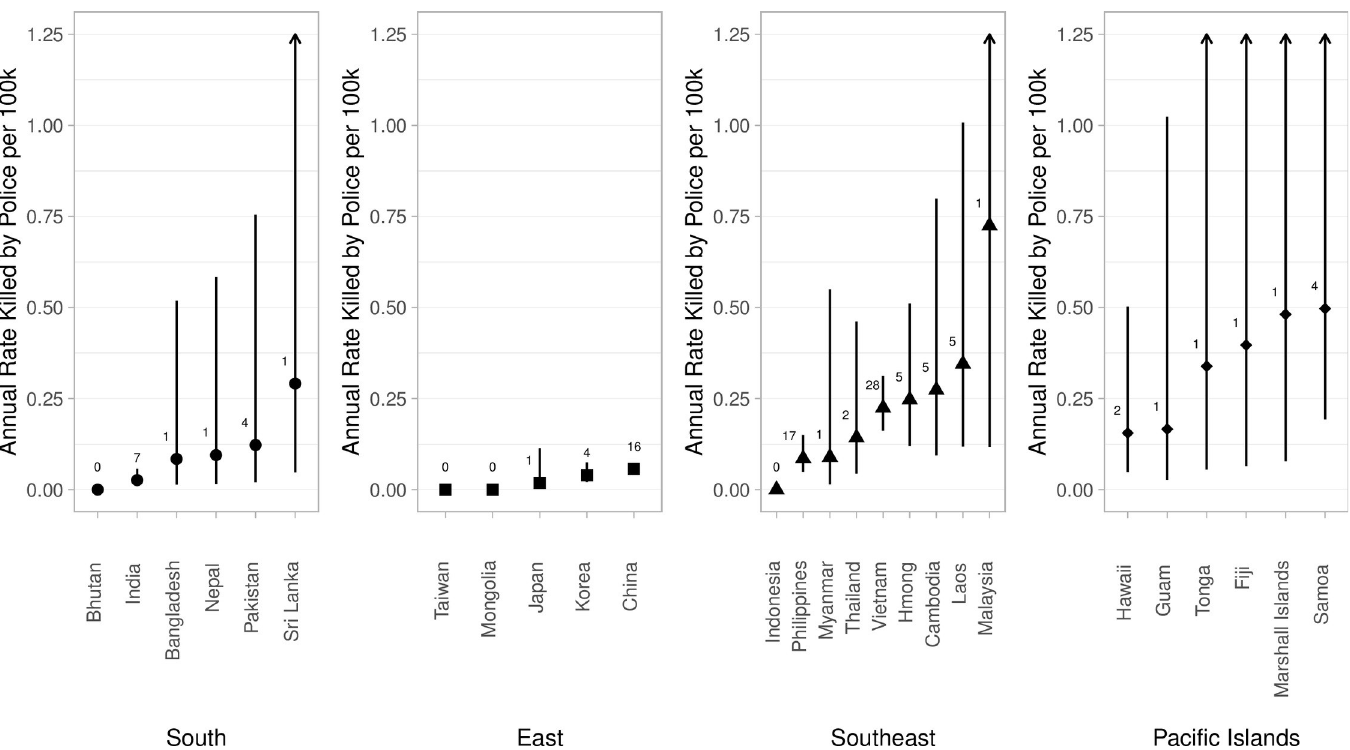
Fig 2. Estimated annual rates of fatal police violence by AAPI national/ethnic background, 2013–2019. Note: Vertical bars represent 95% confidence intervals. Numbers hovering above point estimates represent the number of decedents informing the estimation of each rate, calculated using a single Poisson model. Arrows indicate that confidence intervals extend beyond the Y-axis cut-off; see S4 Table in S1 Appendix. Total numerator N = 109 deaths; 55/167 API decedents were missing national/ethnic background, and an additional 3 from the Federated States of Micronesia lacked a corresponding population denominator from the US Census.